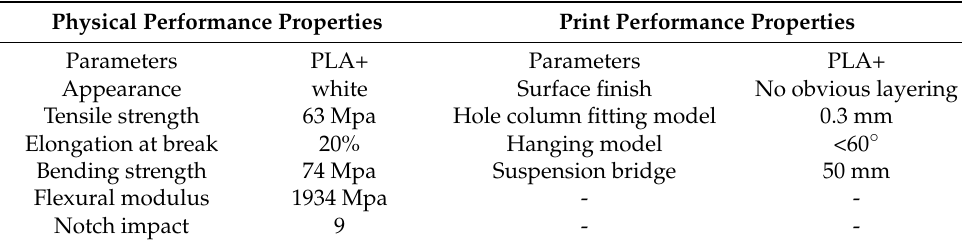
Table 1. Physical and print performance properties of Esun PLA+ filament